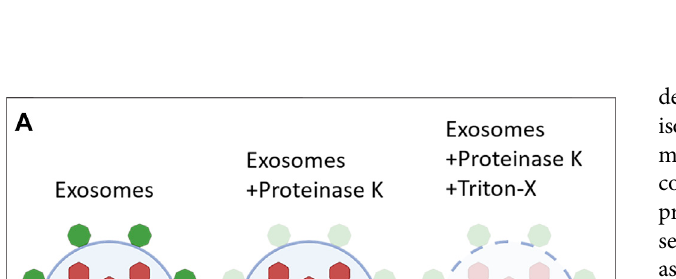
FIGURE3| AnexosomeinhibitorGW4869attenuateseCIRP release. (A) RAW264.7cellsweretreatedwithPBS,LPSorLPS+GW4869.After20 heCIRPlevels ofthesupernatantswereassessedbyWesternblotting.Dataareexpressedasmeans ± SE( n (cid:2) 4samples/group).Thegroupswerecomparedbytwo-wayANOVAand SNK method (* p < 0.05 vs PBS; # p < 0.05 vs LPS). (B) Mice were injected with PBS, LPS or LPS + GW4869. After 4 h the serum was harvested and eCIRP levels were assessed by ELISA. Data are expressed as means ± SE ( n (cid:2) 5 samples/group). The groups were compared by two-way ANOVA and SNK method (* p < 0.05 vs PBS; # p < 0.05 vs LPS). (C) Mice were subjected to sham surgery, CLP or CLP with GW4869 instillation. After 20 h the serum was harvested and eCIRP levels were assessed by ELISA. Data are expressed as means ± SE ( n (cid:2) 6 samples/group). The groups were compared by two-way ANOVA and SNK method (* p < 0.05 vs Sham; # p < 0.05 vs CLP).